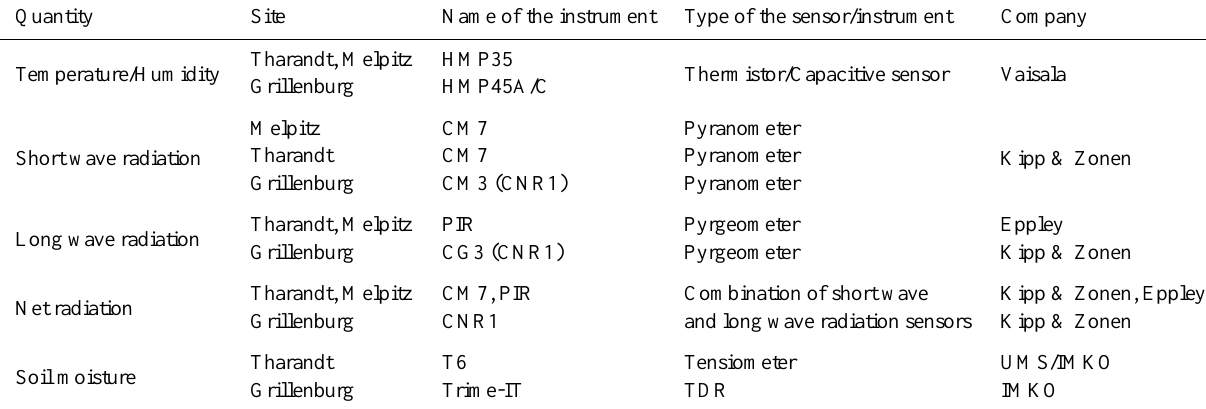
Fig. 1. Scheme of the HIgh Resolution Vegetation Atmosphere Coupler (HIRVAC). Table 1. List of sensors and instruments used for the relevant measurements at the different sites.